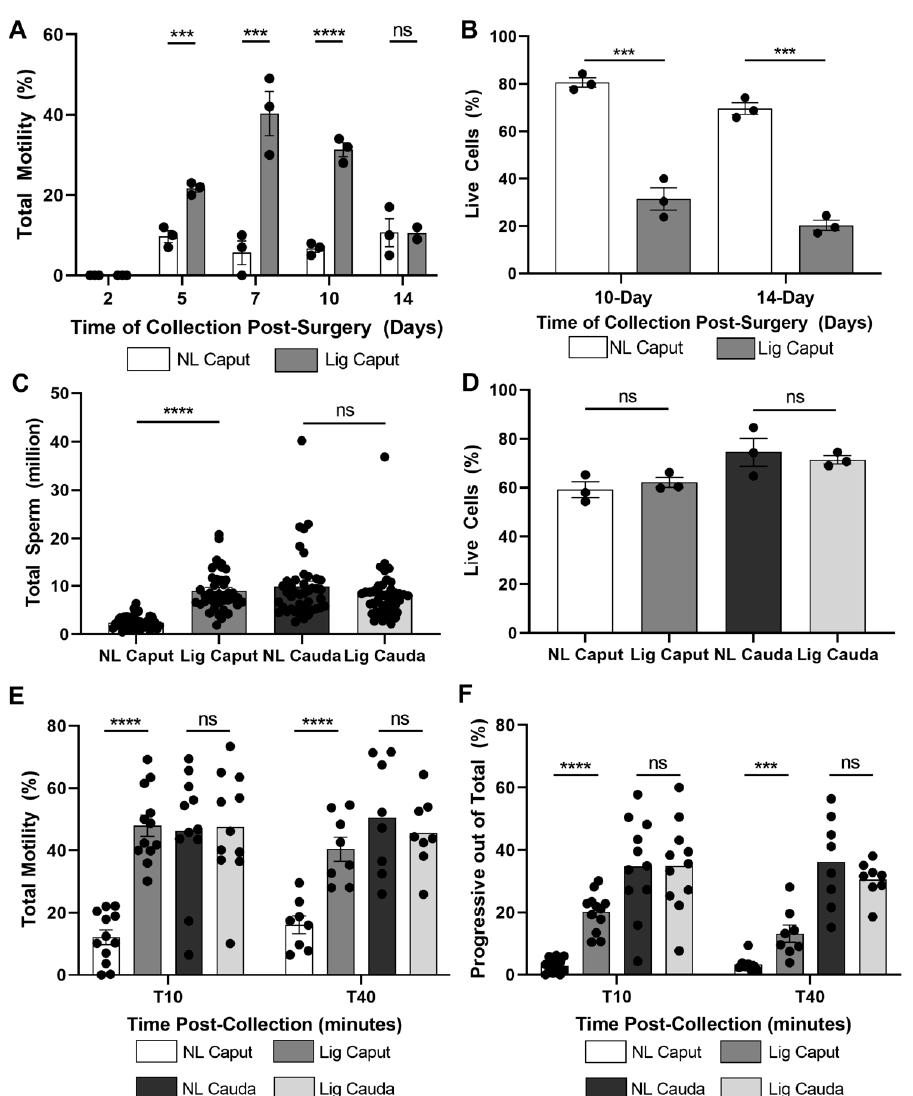
Figure 1. Ligation of the epididymis in the distal caput region induces motility of immature sperm. Comparison of sperm samples collected from the non-ligated caput (NL Caput) region and ligated caput (Lig Caput) region. Sperm samples were incubated in mTYH-capacitating medium supplemented with HCO 3- (25 mM) and BSA (5 mg/mL). Motility was assessed using Computer Assisted Sperm Analysis (CASA). ( A ) Total motility was compared between sperm recovered from the NL Caput and Lig Caput at 2-, 5-, 7-, 10-, and 14-days post-ligation surgery. Total motility was assessed after 10 min in capacitation medium. n = 3. ( B ) Sperm viability from non-ligated caput and ligated caput at 10-days and 14-days post ligation surgery was evaluated with a live–dead assay. n = 3. ( C ) Total sperm recovered from each experimental condition at 7-days post-ligation surgery. n = 42. ( D ) Sperm viability from each experimental condition at 7-days post-ligation surgery was assessed with a live–dead assay. n = 3. ( E ) Total motility during capacitation was further assessed at 10- and 40-min of capacitation in sperm recovered from each experimental condition. T10 n = 12, T40 n = 8. ( F ) Progressive motility out of the total sperm population was analyzed at 10- and 40-min of capacitation in sperm recovered from each experimental condition. T10 n = 12, T40 n = 8. Statistical significance comparing NL Caput vs. Lig Caput and NL Cauda vs. Lig Cauda using Sidak–Bonferroni t -test in all graphs indicated; ns p > 0.05, *** p < 0.001, **** p < 0.0001.